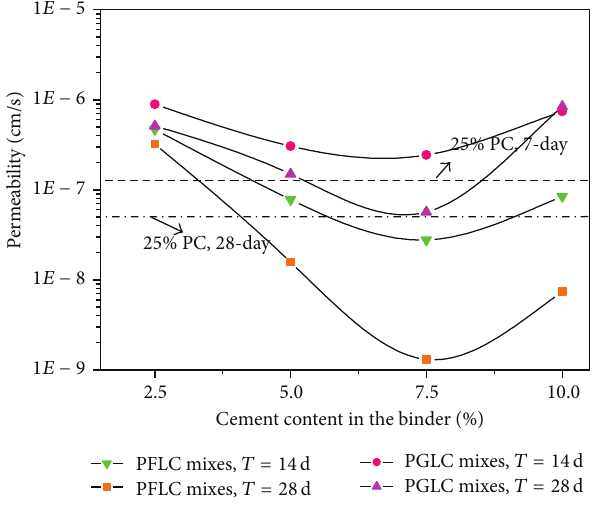
Figure 5: The 28-day permeability of stabilized